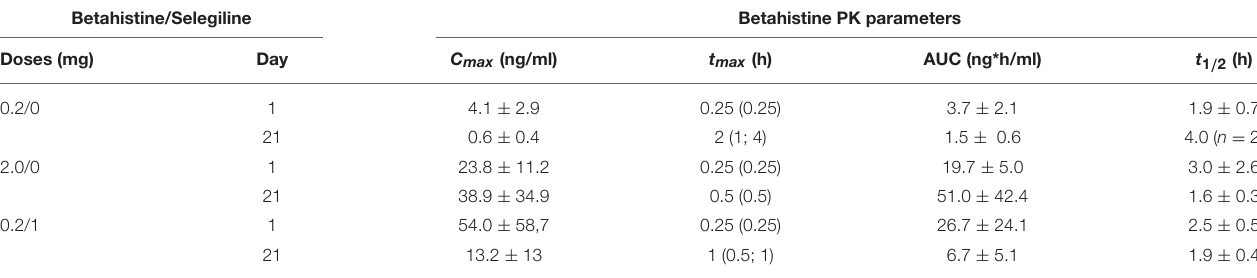
TABLE 1 | Betahistine PK parameters following administration of different doses of betahistine and co-medication of betahistine with the MAO-B inhibitor selegiline. Betahistine/Selegiline